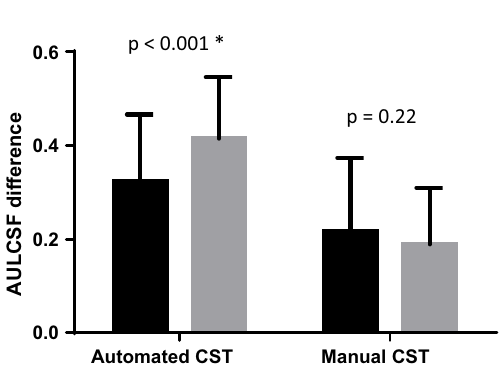
Figure 2. AULCSF difference of photopic and mesopic conditions in automated and manual CST devices according to history of refractive surgery. AULCSF, area under log contrast sensitivity function; CST, contrast sensitivity test. *Statistically significant results.